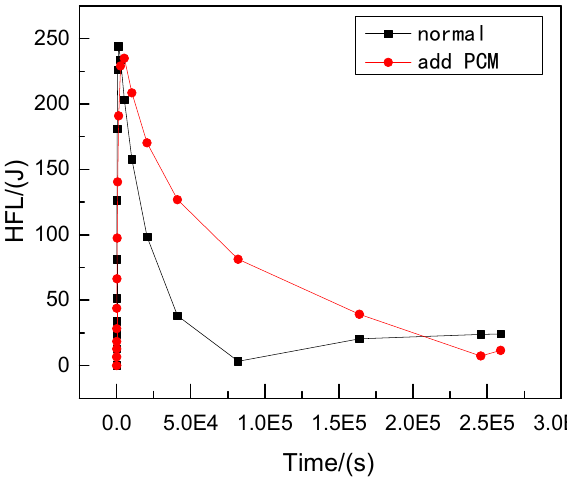
Figure 7. Steady-state heat transfer heat flux characteristic curve (containing decanoic acid).